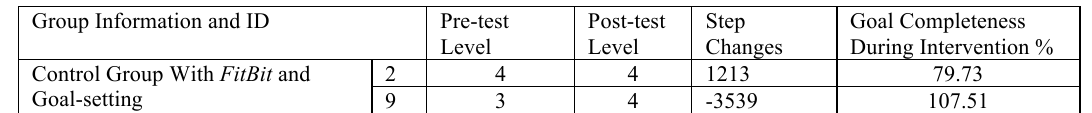
Table 1. Participants’ Cumulative TTM Assessment Results with Steps Data and Goal Completeness, Pre-study and